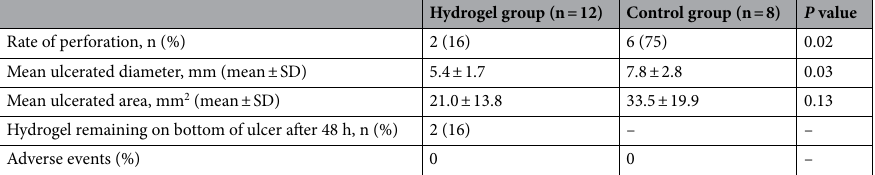
Table 1. Macroscopic findings 48 h after hydrogel or saline application. SD Standard deviation.